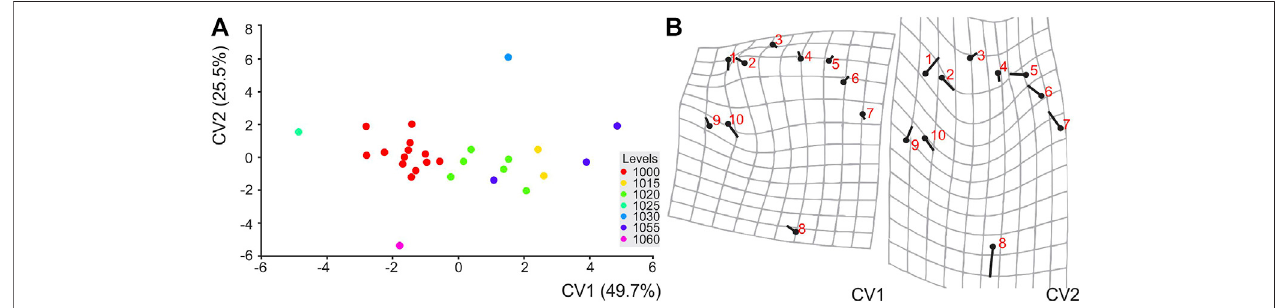
FIGURE 9 | (A) Scatter plot showing the variation in shape of pes tracks of ? Parabrontopus isp. from TCH site along the fi rst two canonical variate (CV1 and CV2) axes.Thereisagradientofseparationoftrackshape bysitelevelacrossCV1. (B) Shapechanges,illustrated bythedeformationgrids,from overallmeanalongCV1and CV2 axes in positive directions. The numbered circles indicate the landmark locations in the mean shape of the sample; the sticks indicate the changes in the relative positions of the